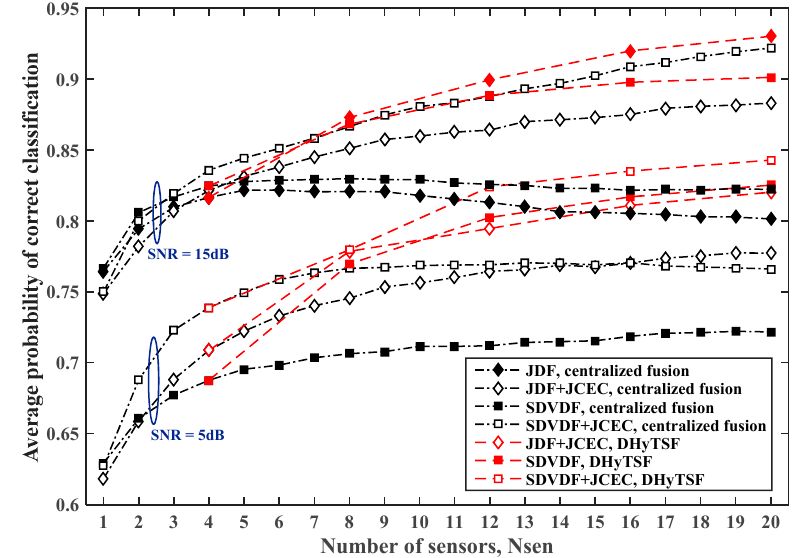
Figure 9. The estimated P CC , avg value for the centralized and distributed cooperative MC in SNS2, for N S = 500 and L max = 5 .